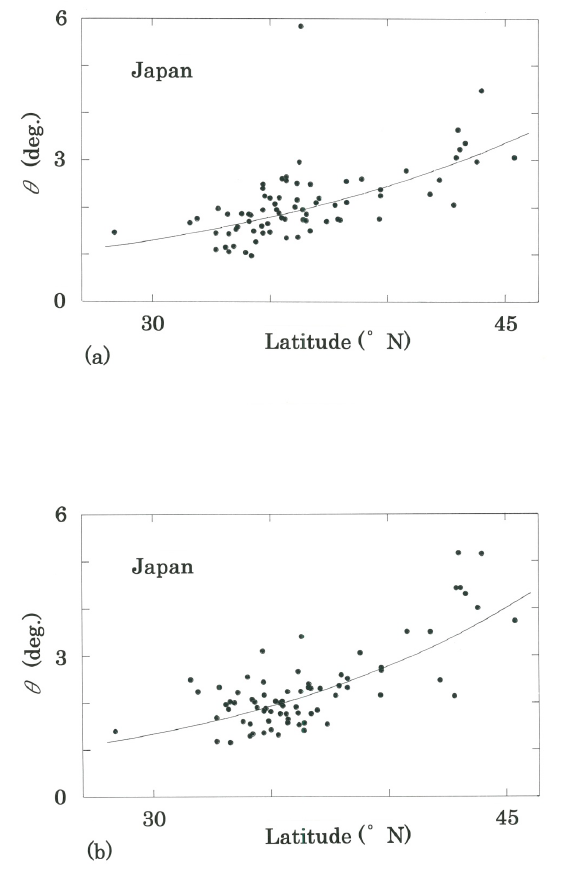
Figure 4. Rotation angles between the monthly distributions of temperatures on the 75 Japanese stations versus their latitudes. ( a ) Rotation from Period I (1931–1960) to Period II (1951–1980) is dealt with. The curve in the plots represents the optimal exponential regression ( r = 0.642 with d = 1.867 > d U = 1.50 for n = 75). ( b ) Rotation from Period II (1951 ‐ 1980) to Period III (1981 ‐ 2010). The curve in the plots represents the optimal exponential regression ( r = 0.723 with d = 1.616 > d U = 1.50 for n = 75).